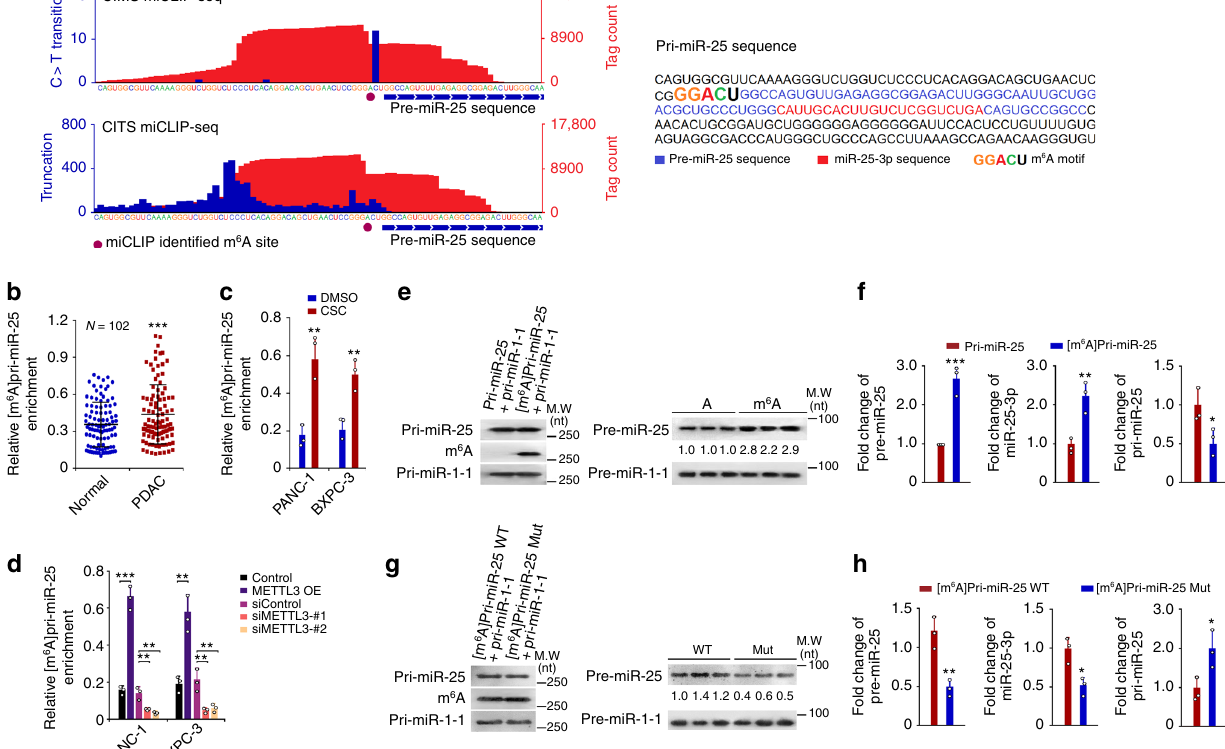
Fig. 3 m 6 A modi fi cation is a major mechanism for METTL3-promoted pri-miR-25 maturation. a Left: Identi fi cation of m 6 A by m 6 A individual-nucleotide resolution cross-linking and immunoprecipitation sequencing (miCLIP-seq). The m 6 A residues were detected by cross-linking induced mutation sites (CIMS) and cross-linking induced truncation sites (CITS) in pri-miR-25. Red tracks of miCLIP-seq are unique tag coverage and blue tracks represent C>T transition or truncation, respectively. Filled purple circles denote miCLIP-called m 6 A and the horizontal blue bars indicate transcript models of pre-miR-25. Right: The sequences of pre-miR-25 and miR-25-3p are highlighted, respectively, by different colors, and the m 6 A motif (GGACU) is located at the putative splicing site. b PDAC had signi fi cantly higher levels of [m 6 A]pri-miR-25 than paired non-tumor tissues. [m 6 A]pri-miR-25 was detected by immunoprecipitation followed by qRT-PCR analysis. *** P < 0.001 by Wilcoxon rank-sum test. c , d Effects of CSC exposure (100 µ g/ml) and overexpression or knockdown of METTL3 on the levels of [m 6 A]pri-miR-25 in PDAC cells. Data represent mean ± S.D. from three independent experiments. e , f m 6 A modi fi cation substantially enhanced pri-miR-25 processing and maturation in an in vitro reaction system containing starting materials of pri-miR-25 or [m 6 A]pri-miR-25 and the whole cellular lysates of 293T cells transfected with plasmids carrying DROSHA and DGCR8. Pri-miR-1-1 which has no methylation site was included as a control. e Northern blot detection of starting materials (left panel) and the levels of resultants pre-miR-25 and pre-miR- 1-1 in the reaction. f Quanti fi cation of pre-miR-25, miR-25-3p, and pri-miR-25 in the reaction mixture. Data represent fold change ± S.D. relative to pri-miR- 25 as starting material. g , h Mutation of [m 6 A]pri-miR-25 at METTL3-recognizing site abolished pri-miR-25 processing and maturation in the in vitro reaction system. g Northern blot detection of starting materials (left panel) and the levels of resultants pre-miR-25 and pre-miR-1-1 in the reaction. h Quanti fi cation of pre-miR-25, miR-25-3p, and pri-miR-25 in the reaction mixture. Data represent fold change ± S.D. relative to [m 6 A]pri-miR-25 WT as starting material from three experiments. All statistic analyses in this fi gure are Student t test unless speci fi ed. * P < 0.05, ** P < 0.01, and *** P < 0.001 compared with the corresponding control NATURE COMMUNICATIONS| (2019) 10:1858 |https://doi.org/10.1038/s41467-019-09712-x|www.nature.com/naturecommunications